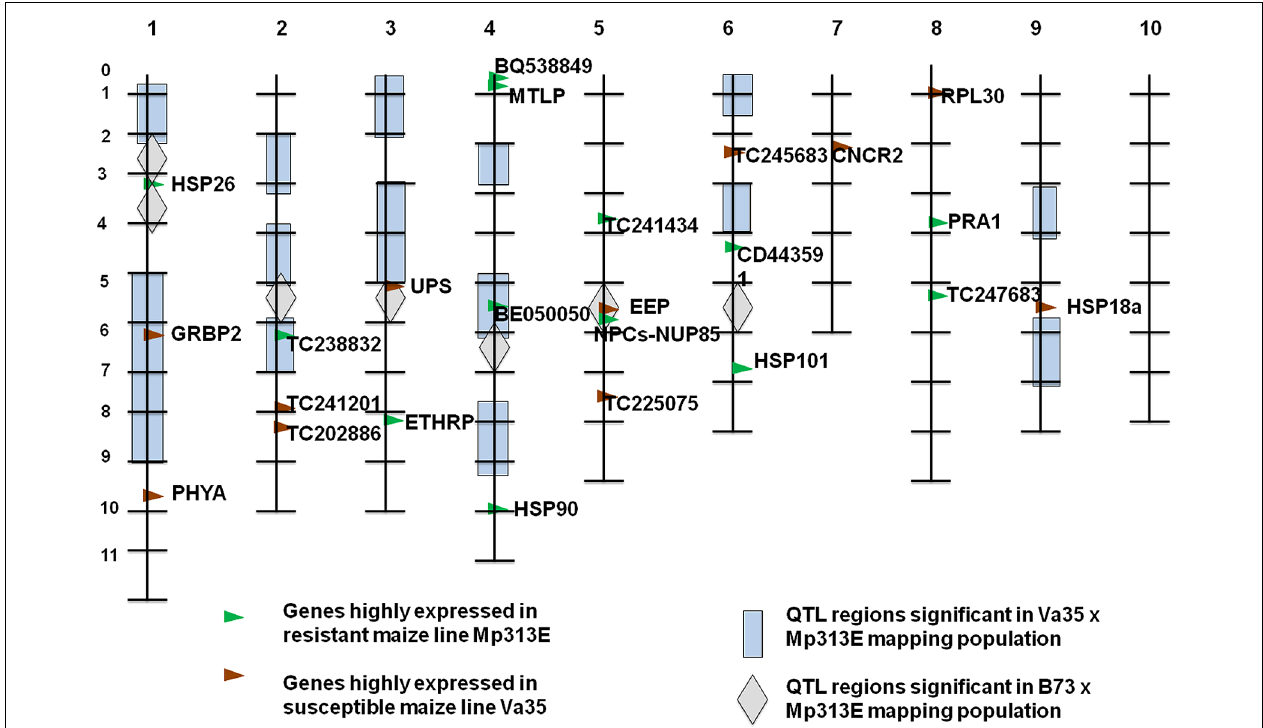
FIGURE 1 | Chromosome bin map showing the positions of the identified QTL regions from the two Mp313E-derived QTL mapping populations. The significant genes marked in the map were from a separate genome-wide microarray study. Eight genes were located to